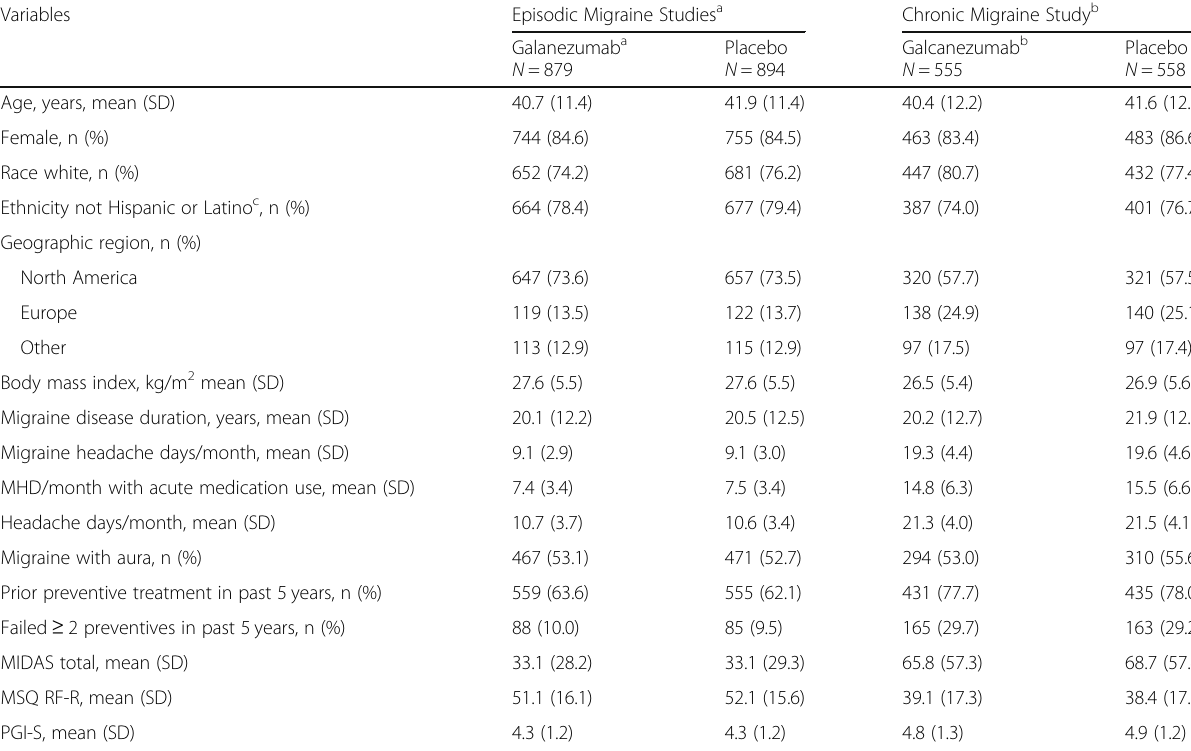
Table 1 Patient demographics and disease characteristics of galcanezumab -treated patients from episodic and chronic migraine trials Variables